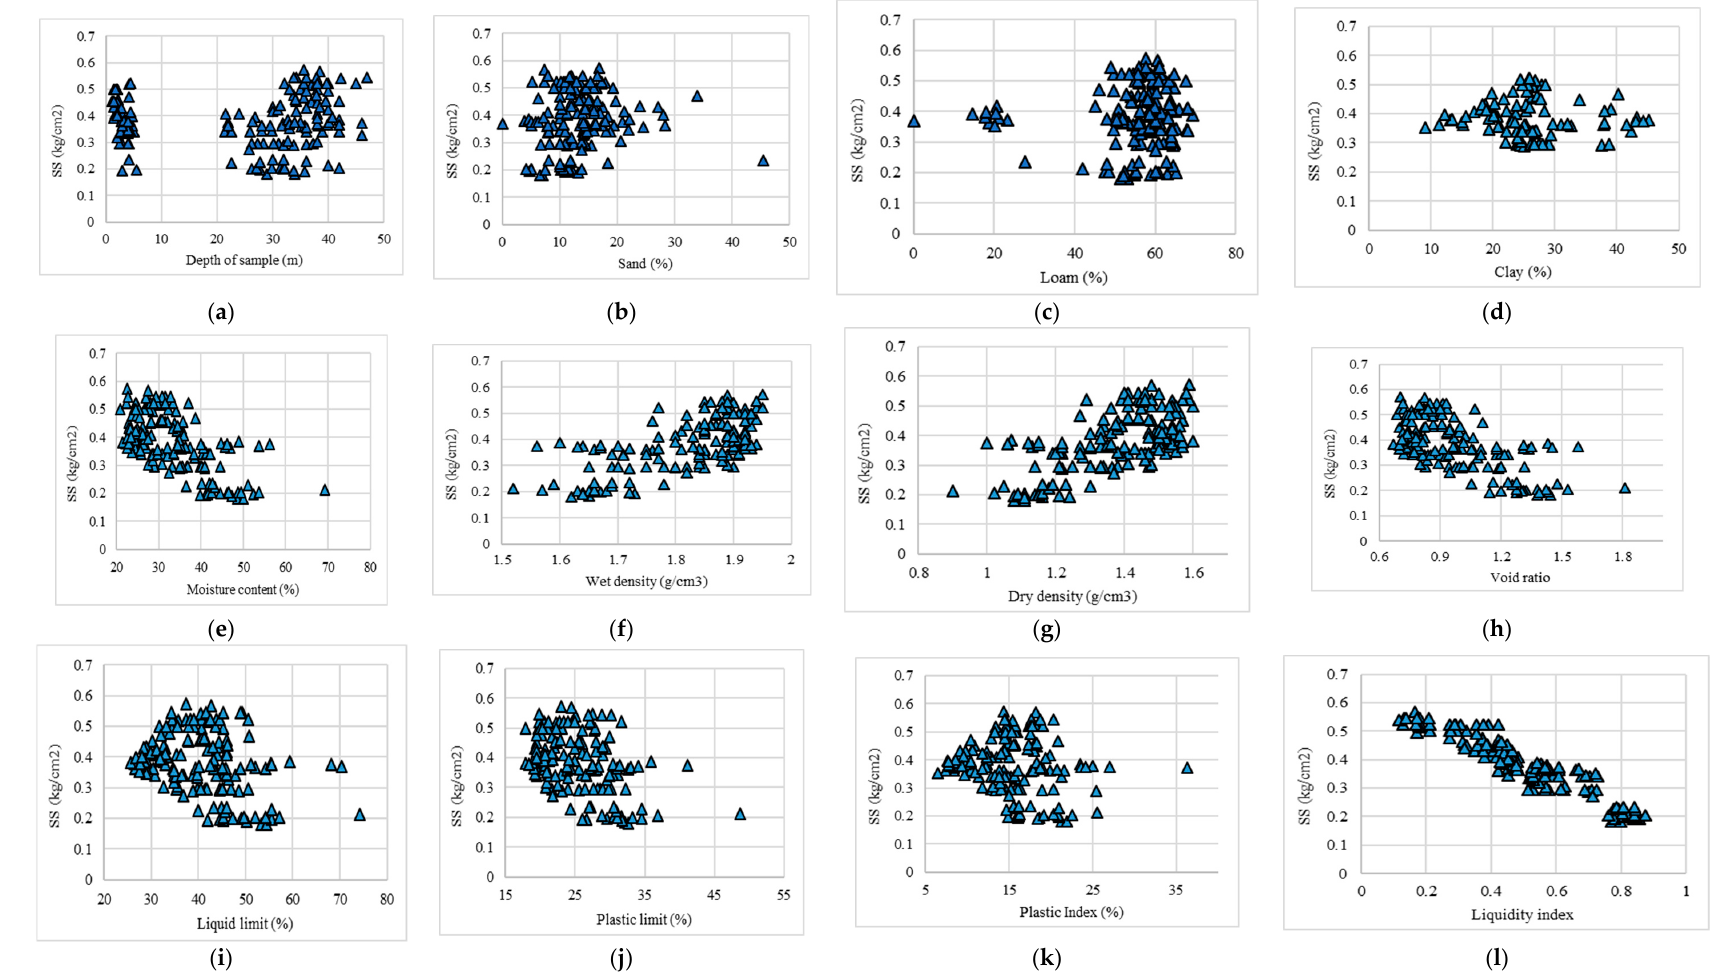
Figure 6. Distribution of shear strength values versus soil parameters.